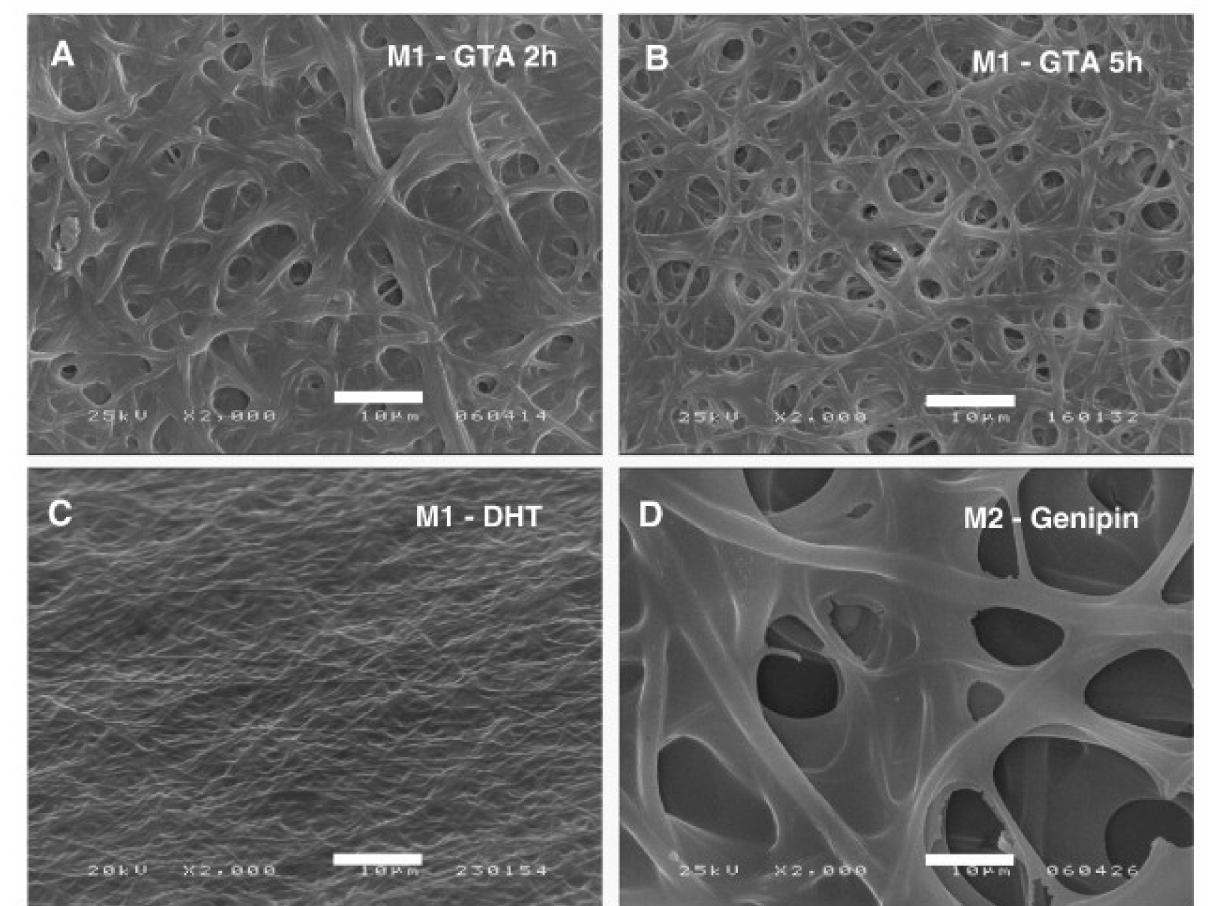
Figure 2. Scanning electron microscopy (SEM) images after immersion in Dulbecco’s modified Eagle medium (DMEM) for 3 days of: pure gelatin nanofiber mat crosslinked by ( A ) GTA 2 h; ( B ) GTA 5 h; ( C ) DHT; and ( D ) gelatin/genipin nanofiber mat (scale bar = 10 µ m). Reprinted from [36]. Copyright 2021